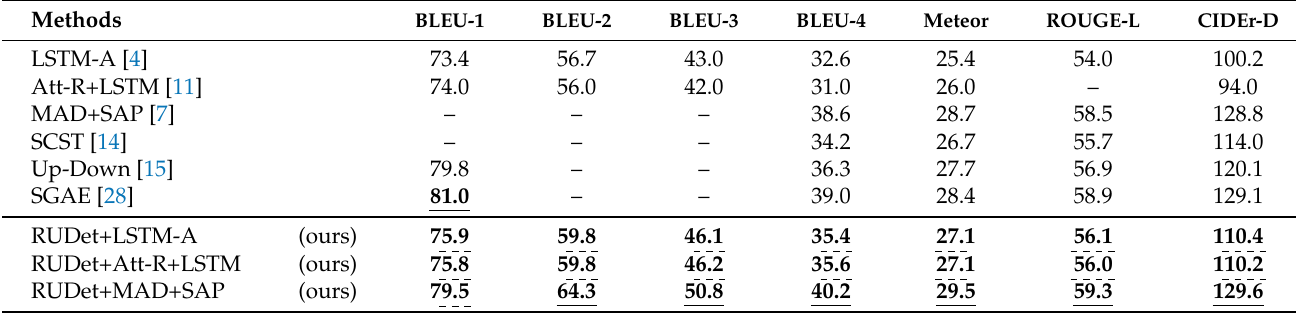
Table 4. The comparison with other methods in caption generation. In the first column, “RUDet+” means using the attributes detected by the proposed RUDet. The symbol “–” means that the authors did not provide the values of the corresponding metrics. In each column, the highest values are marked by underline , and other values improved by our method are marked by dashed underline